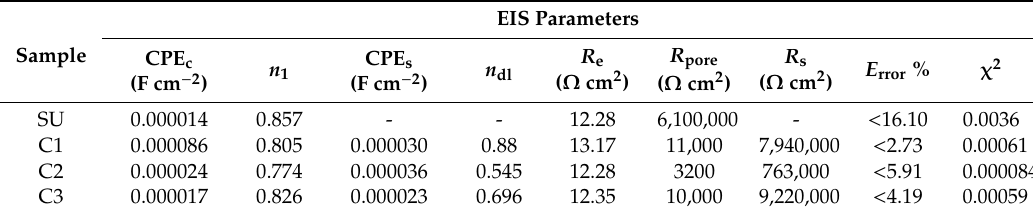
Table 2. EIS data obtained by equivalent circuit simulation of coated and uncoated specimens exposed in 3.5 wt.% NaCl